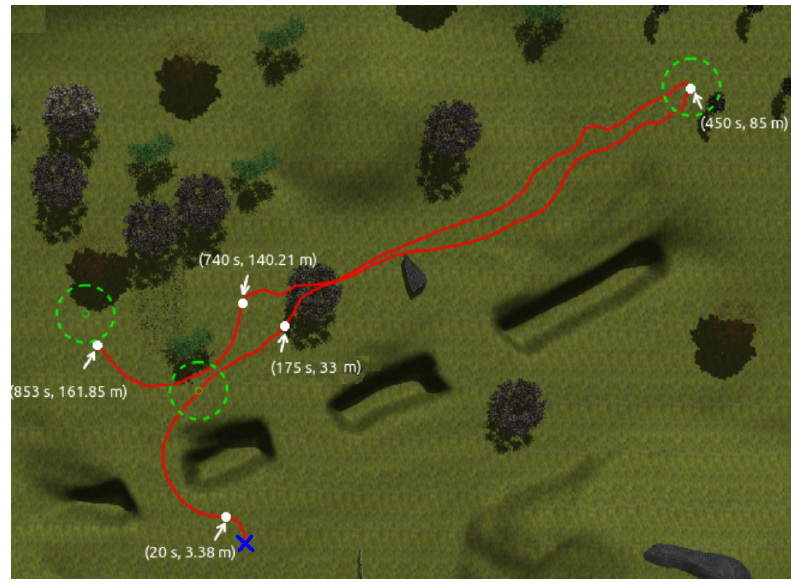
Figure 21. Path followed by the robot with time and distance